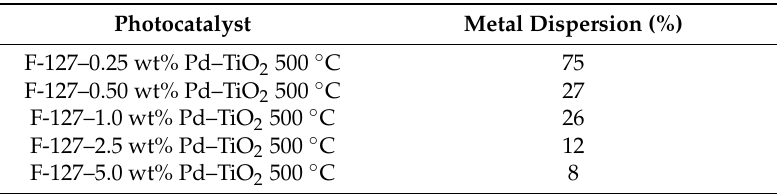
Table 3. Chemisorption analysis: metal